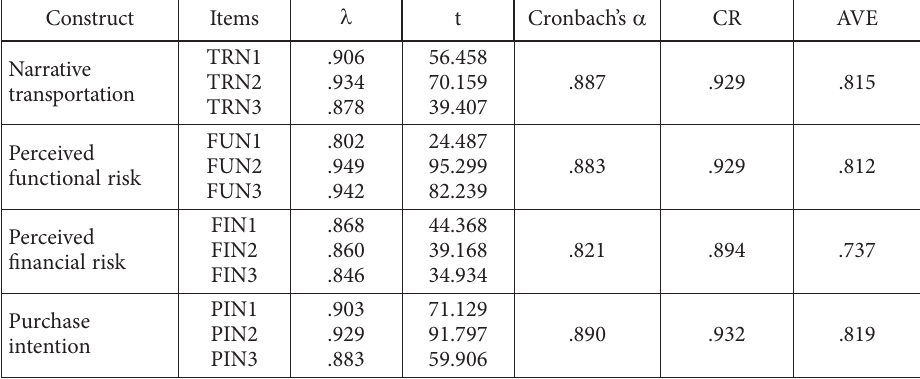
Table 1. Measurement items and construct evaluation